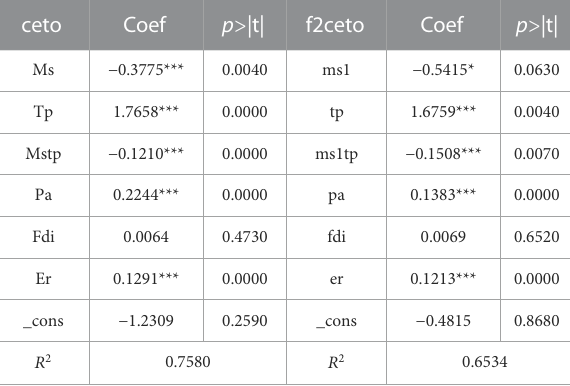
TABLE 5 Fixed-effects model estimates of the dependent variable with a lag of 2 years. f2ceto